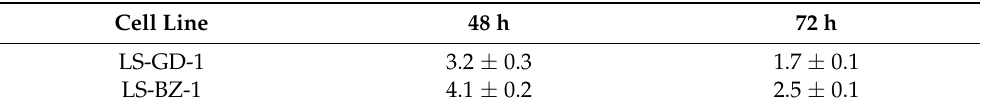
Table 1. In vitro cytotoxic activity of RHPS4 on DDLPS cell lines, reported as IC 50 ( µ M) at 48 and 72